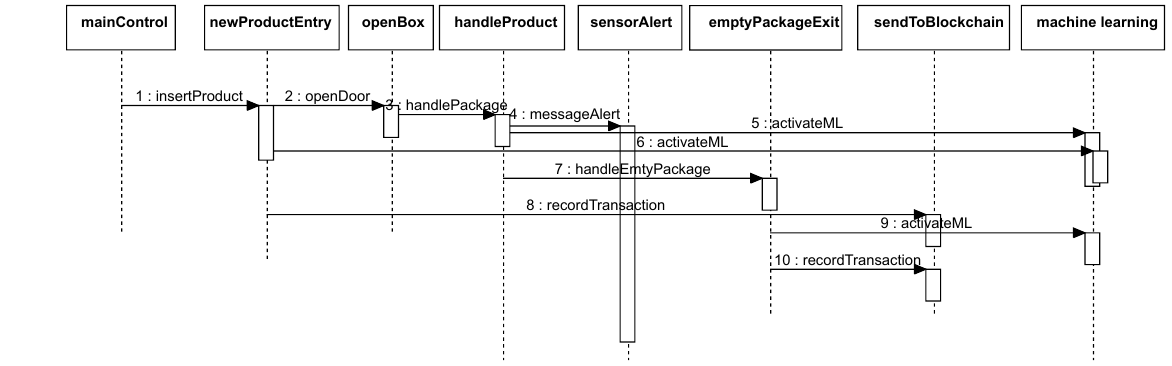
Figure 9. Relationship among tier 2 functionalities in